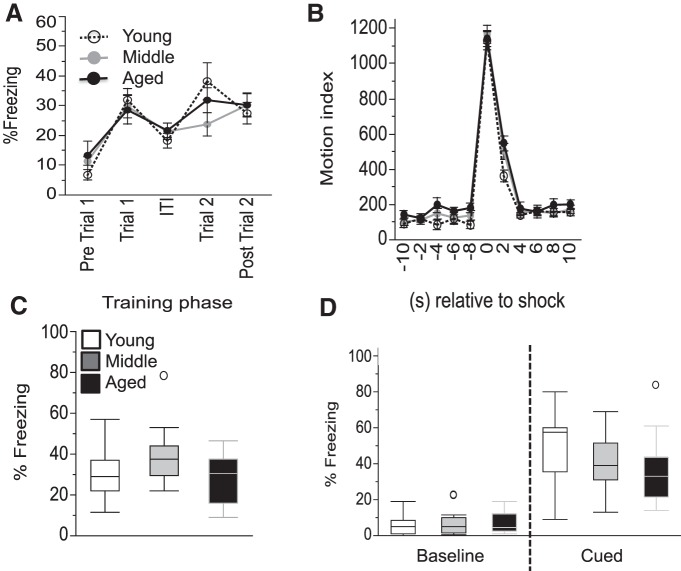
Contextual and cued fear conditioning training and testing are largely unaffected by age. A, The time course of freezing throughout the training is shown. Trial 1 and 2 refer to the first and second pairings of the NS or CS with the UCS. B, The time course of the motor responses in the training phase relative to the footshock is shown with a 2 s resolution using average values from the two trials. C, Percentage of freezing during the contextual FC test is shown. D, Percentage of freezing during the baseline and cued phase of the cued FC test is shown. Values are expressed as the mean ± SEM (A, B) or box plots, as defined in the Data analysis section in Materials and Methods (C, D). NS, Neutral stimuli.